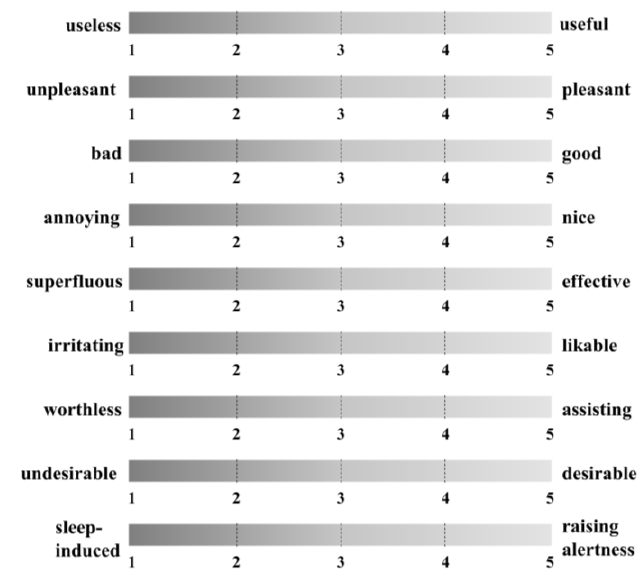
Figure 4. The subjective rating metrics of FCW trigger timing.